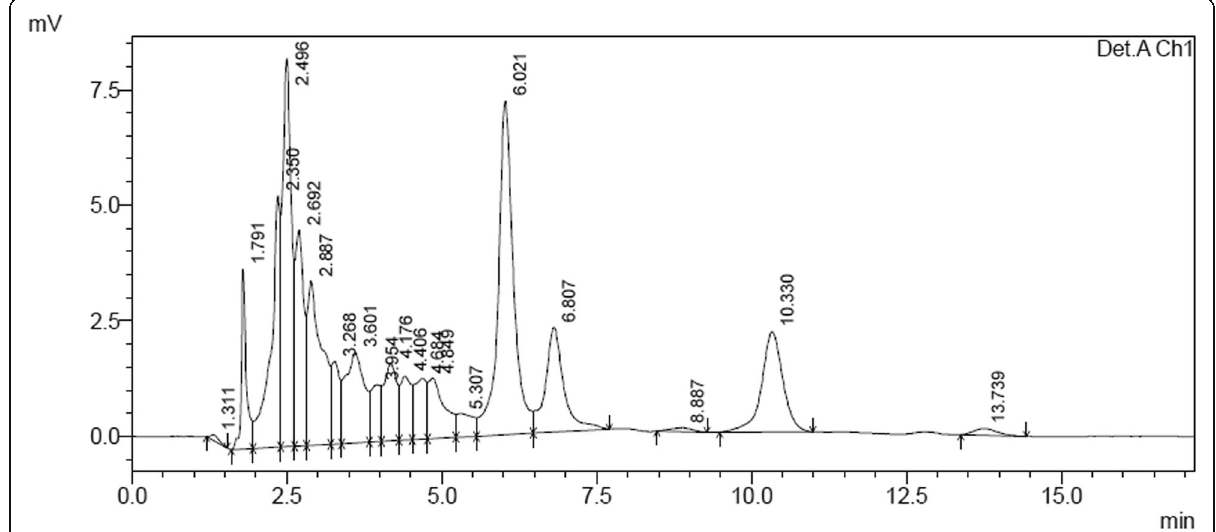
Fig. 3 Chromatogram of HQC